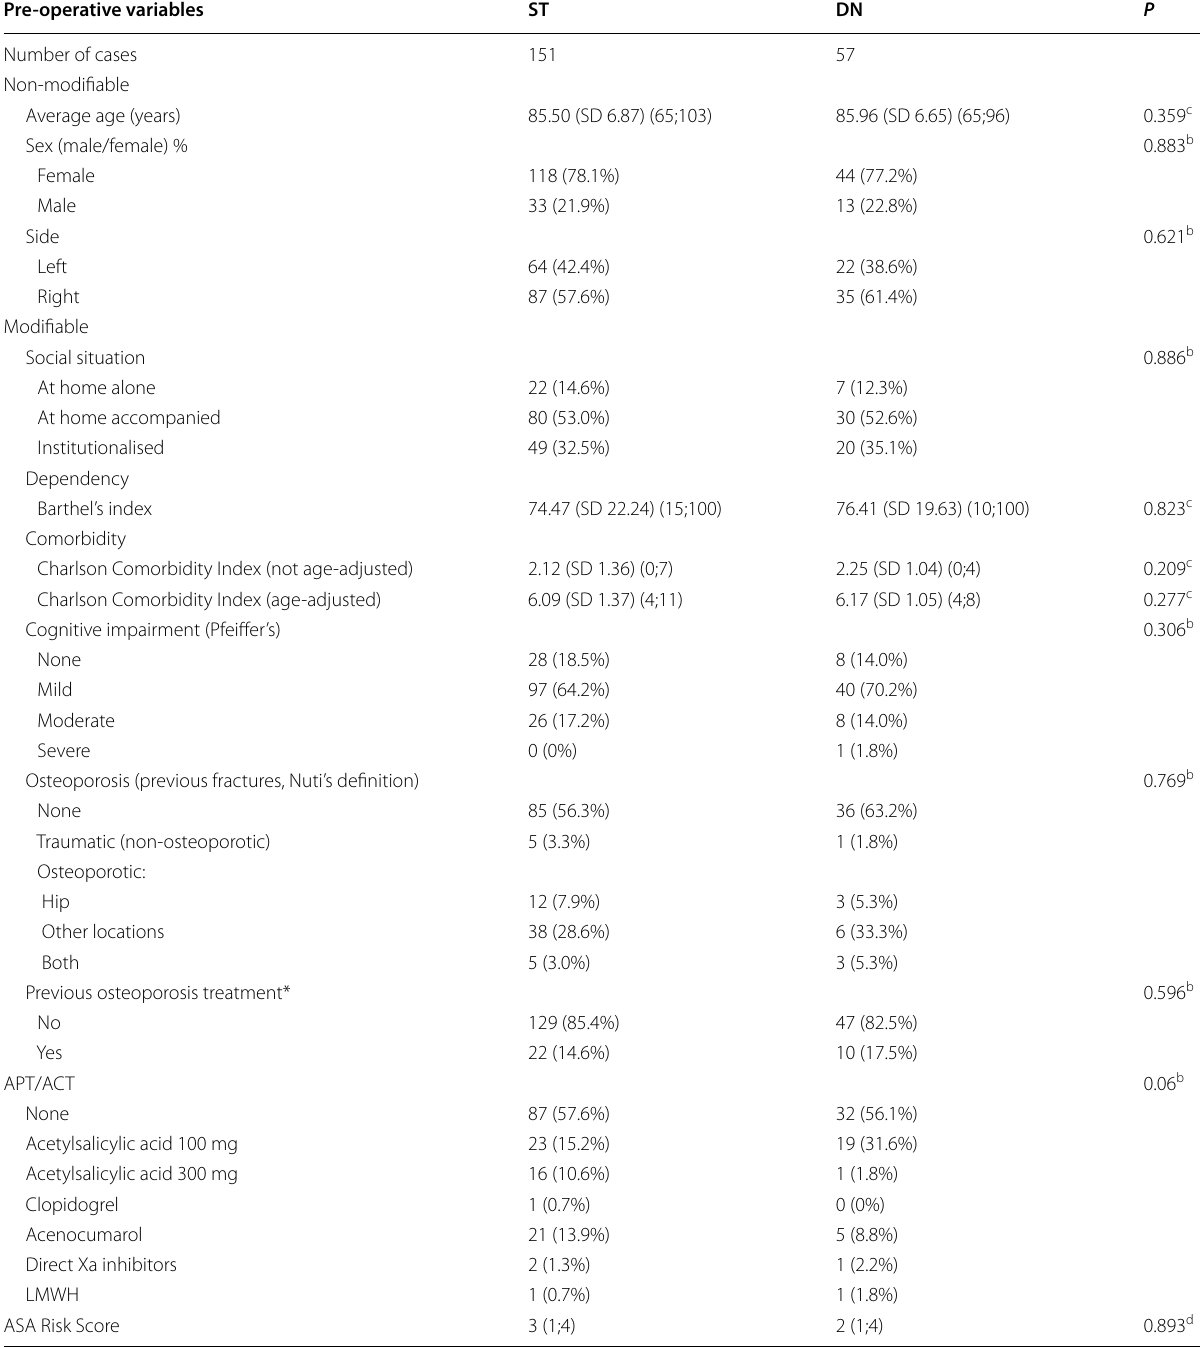
Table 2 Pre‑operative